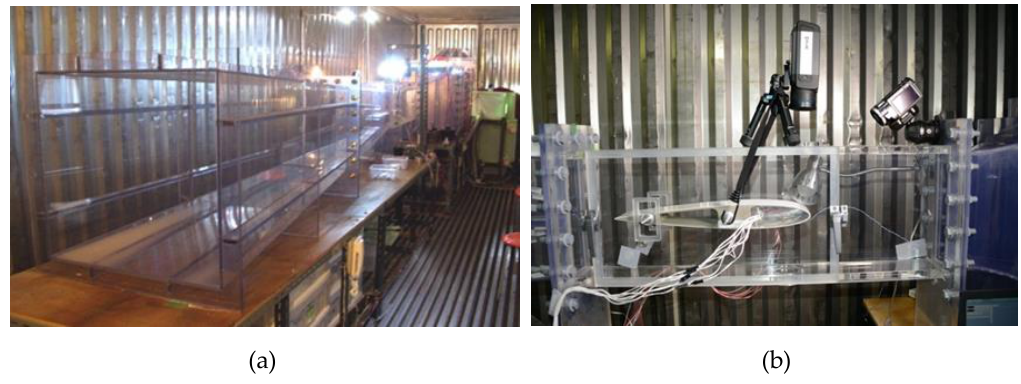
Figure 2. KAIT Icing Wind Tunnel: ( a ) overview from downstream and ( b ) test section.